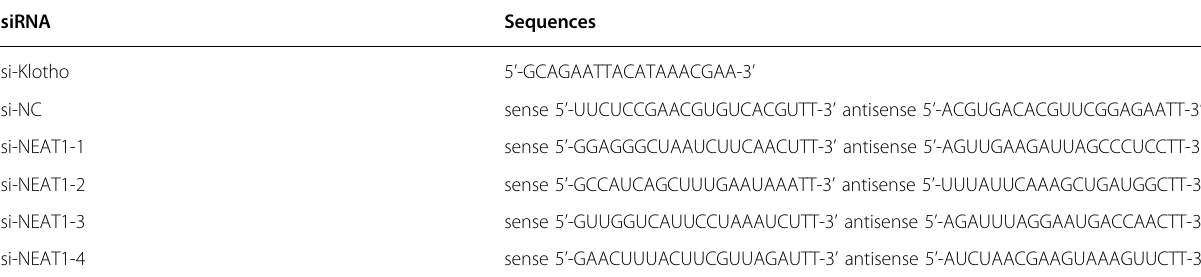
Table 2. The expression of each gene was calculated using Table 1 Sequences of siRNAs.